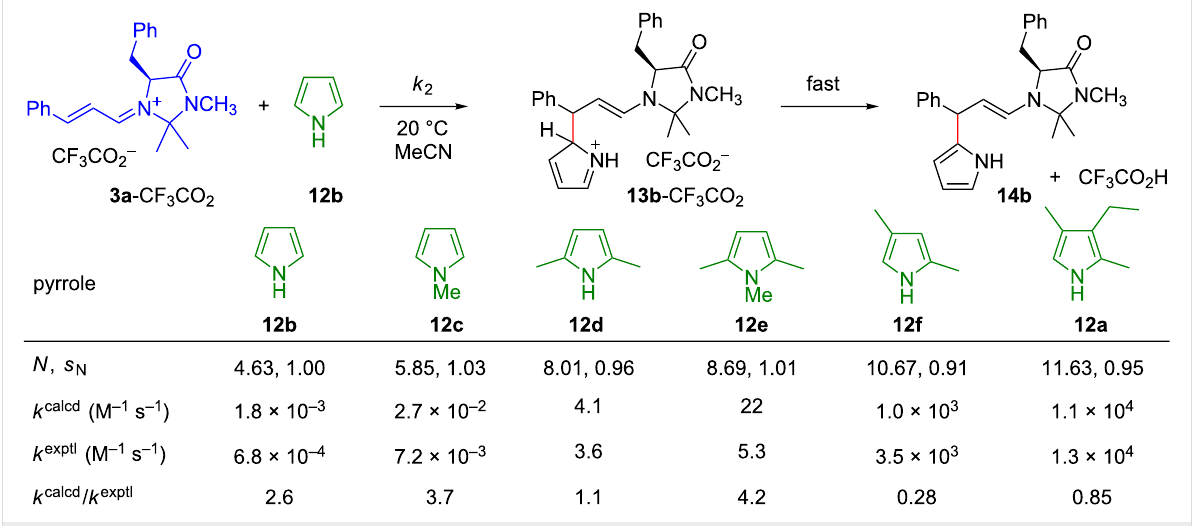
Figure 9: Comparison of calculated and experimental rate constants of electrophilic aromatic substitutions with iminium ions [56].